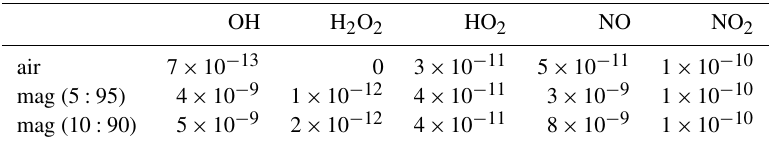
Figure 6. The temporal evolution of different modeled bromine species’ ratios (molar) over the model time of 25min with the respective measurement data (if available). Each subfigure shows the model runs that are closest to the measurement data, derived by the fit comparison. Table 8. H x O y and NO x species used for the initialization of the CAABA/MECCA model